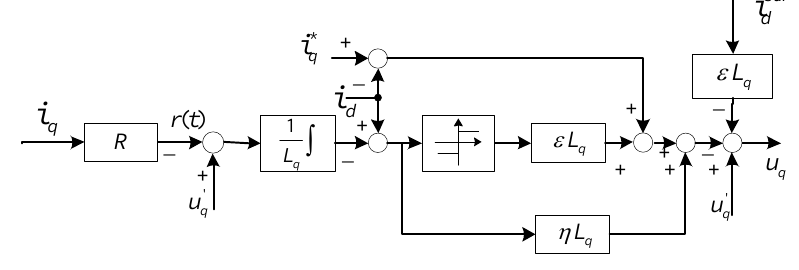
Figure 5. The q -axis current diagram of SMC. Energies 2017 , 10 , 1609